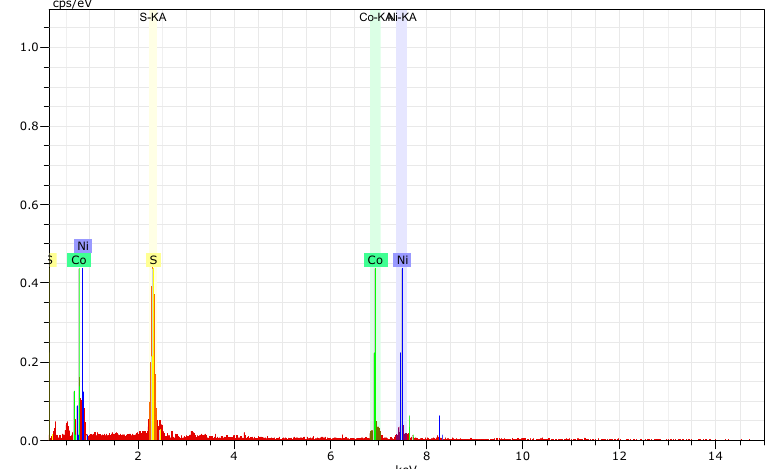
Figure A2. EDX spectra of Co 0.6 Ni 0.4 S 2 /rGO sample.